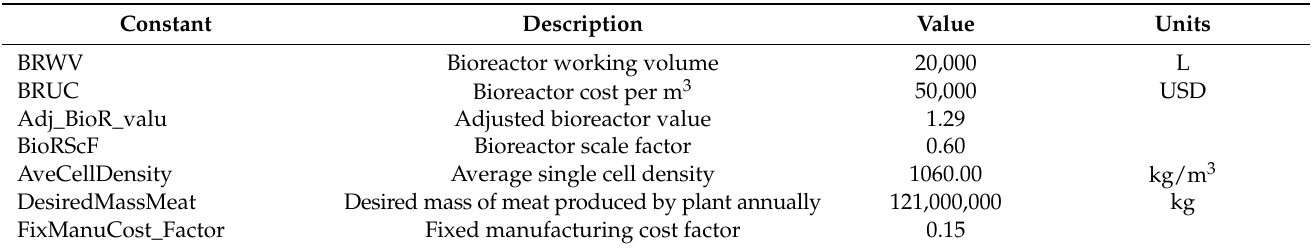
Table A3. Constants used in calculations. Values remained unchanged between mammalian and insect